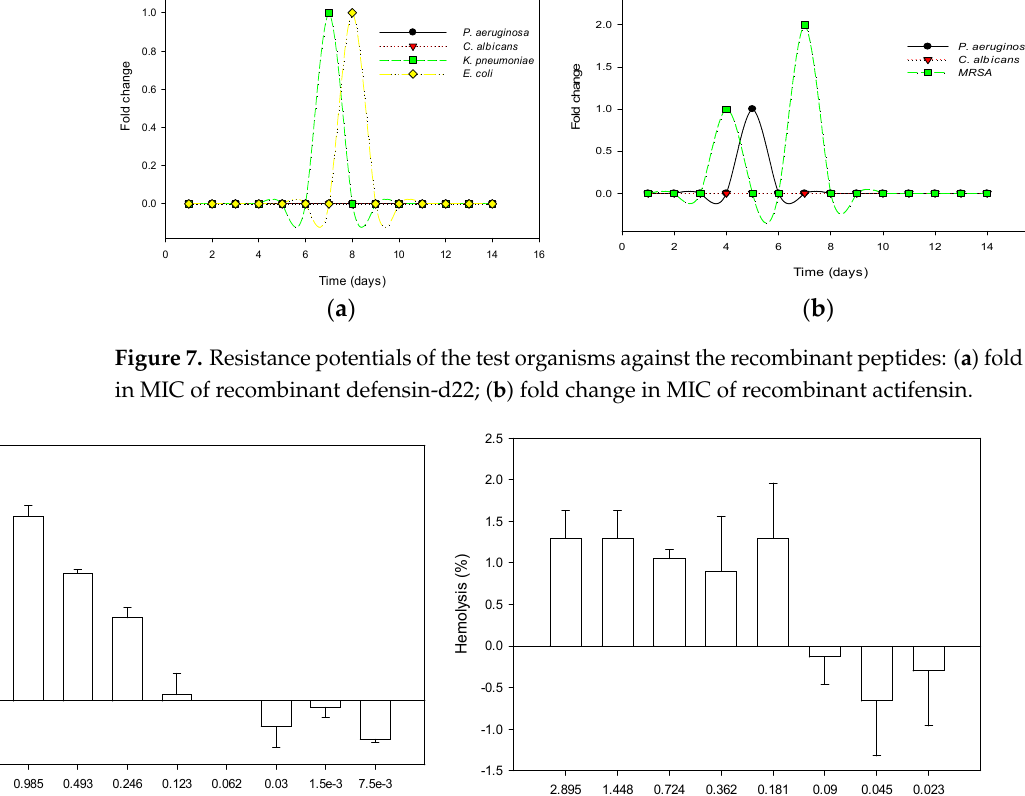
Figure 8. Hemolytic activity of ( a ) recombinant defensin-d2 and ( b ) recombinant actifensin. Graph shows means and standard error means (as error bars) of triplicate data per concentration.